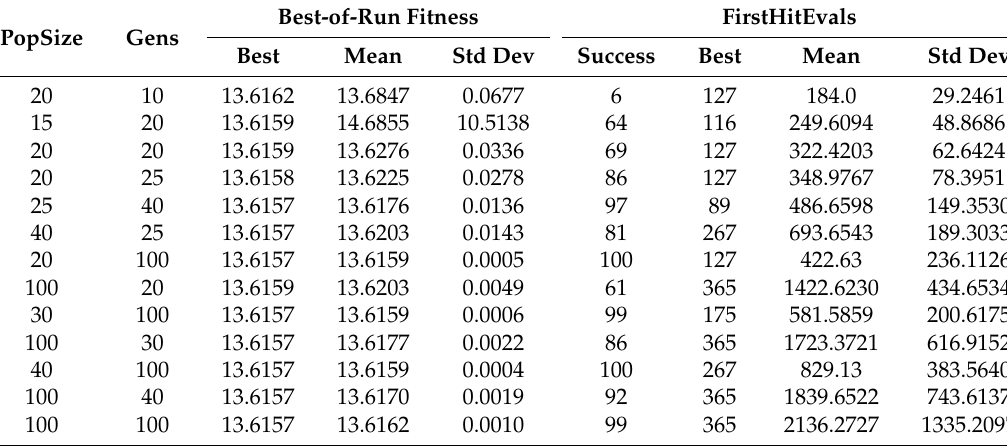
Table 12. Results of SJaya on the fuel cell problem (each row corresponds to 100 independent runs). Most numbers are shown with rounding at the fourth place after the decimal.